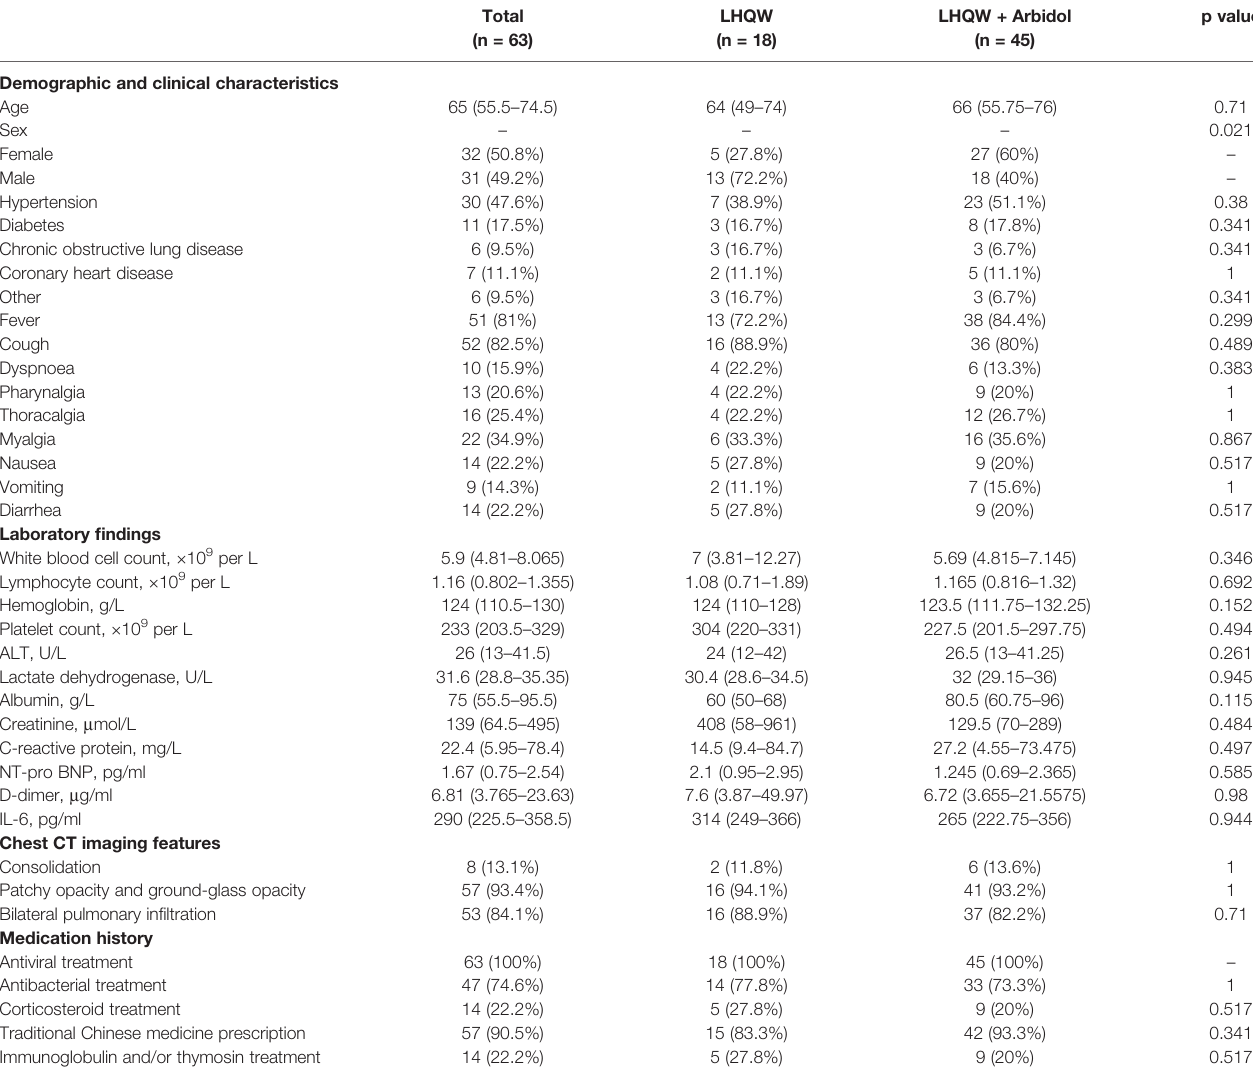
TABLE 2 | Demographic, clinical, laboratory, and radiographic characteristics and the medication history of patients with severe